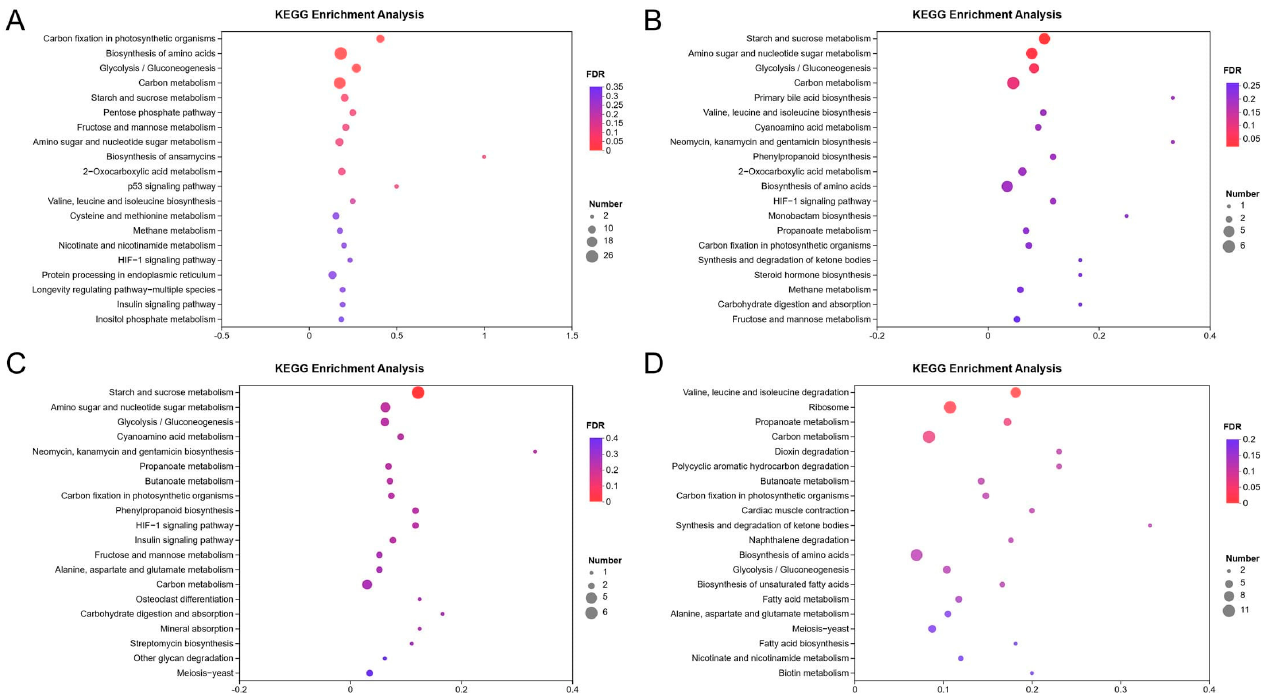
Figure 4. Bubble diagram of KEGG pathways of upregulated DEGs in T. harzianum T4 grown for ( A ) 12 h, ( B ) 24 h, ( C ) 48 h and ( D ) 72 h in the presence of ( A ) 12 h, ( B ) 24 h, ( C ) 48 h and ( D ) 72 h in the presence of BCCW.